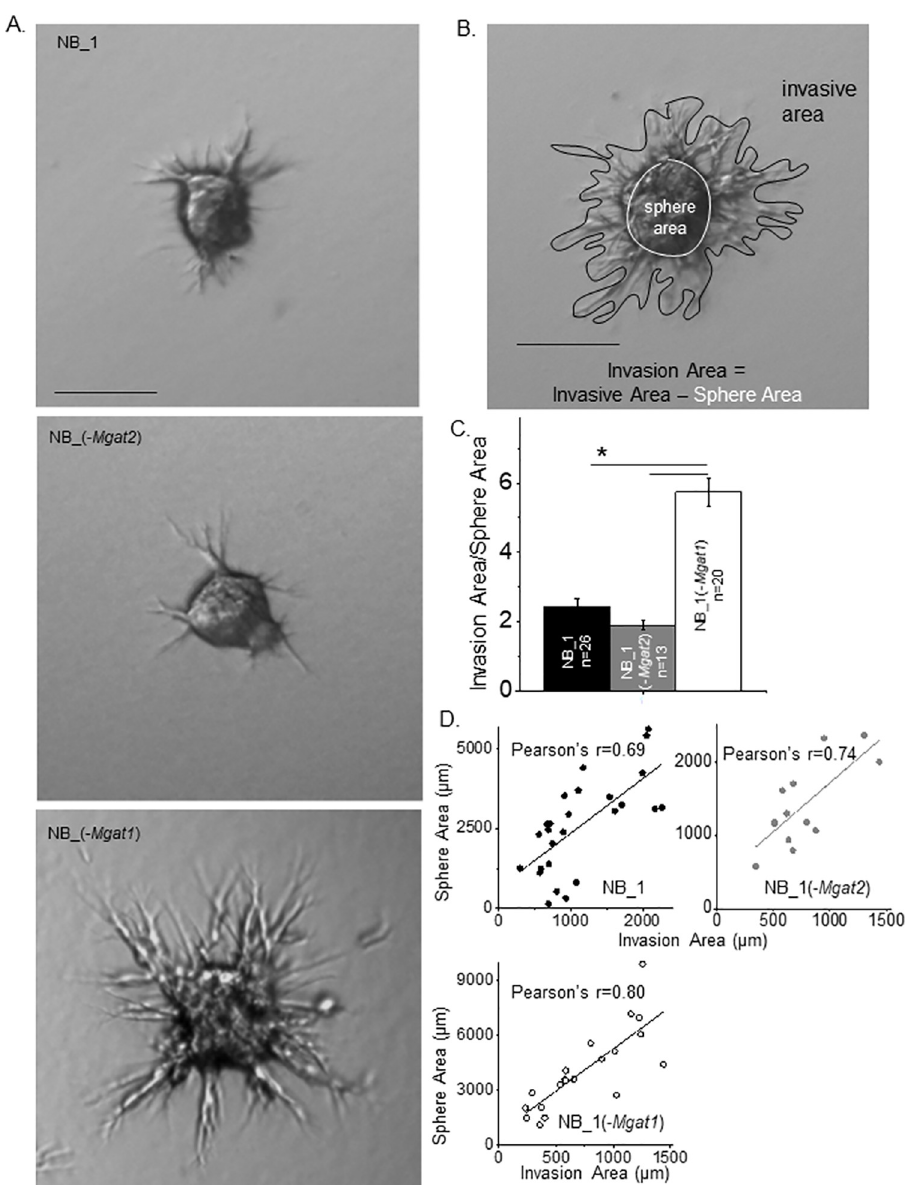
Fig 5. Disruption in the N-glycosylation pathway modifies 3D cell invasion. (A) Images of representative cell invasiveness from 1-day old spheroids of parental and N-glycosylation mutant cell lines cultured for 24 h in Matrigel matrix. (B) Micrograph of invading spheroid cells indicating measured sphere and invasive areas. Scale bars represent 25 μ m. (C) The ratio of the invasion area to the sphere area were determined and plotted for NB_1 ( n = 22), NB_1 (- Mgat2 ) ( n = 15) and NB_1(- Mgat1 ) ( n = 18) cell lines. (D) Pearson’s correlation coefficients from plots of sphere area versus invasion area for each cell line. Data are presented as the mean ± SEM and were compared by one-way ANOVA using Holm-Bonferroni test ( � p < 0.05). n denotes number of spheroids measured. spheroids invaded for 24 h, respectively (Fig 6F). Increases were also measured for average cell invasion values for NB_1 and NB_1(- Mgat2 ) when the invasion time was increased from 18 h to 24 h. When comparing all 3D spheroid invasion assays, cell invasiveness was greatest in the NB_1(- Mgat1 ) cell line, intermediate for the NB_1 cell line and least in the NB_1(- Mgat2 ) cell line. Based on Pearson’s correlation coefficeints, cell invasion area was dependent on sphere